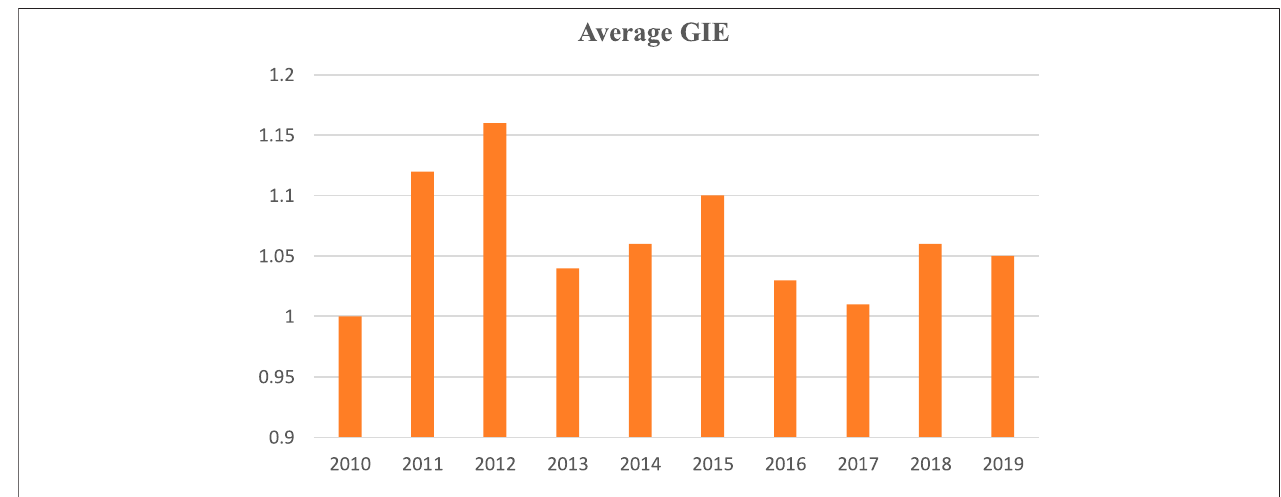
FIGURE 1 | Average green innovation ef fi